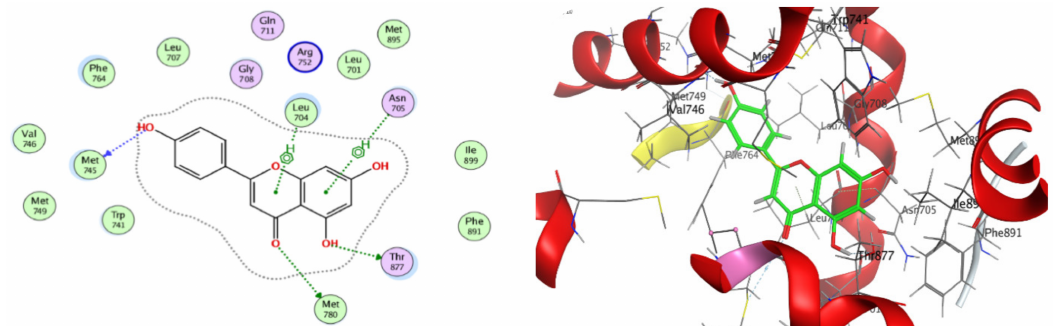
Figure 8. Molecular docking process of kaempferol with 2Q7L protein.